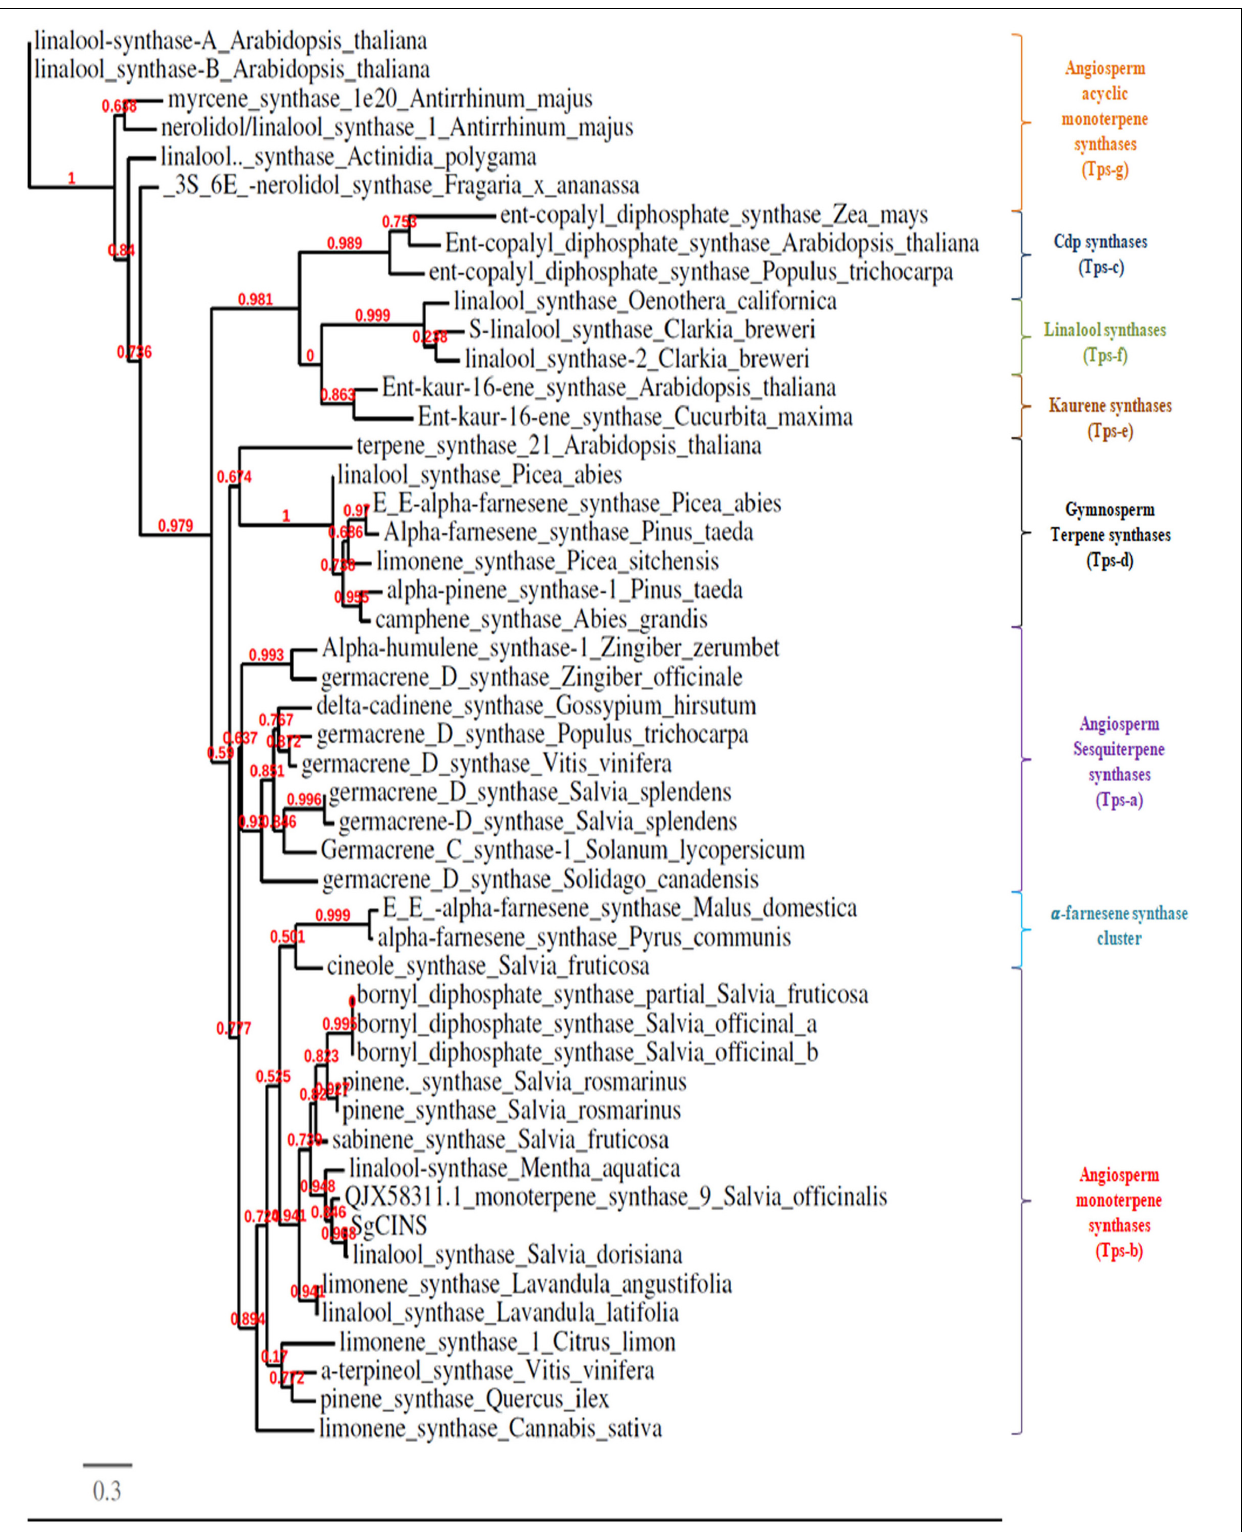
Frontiers in Plant Science |